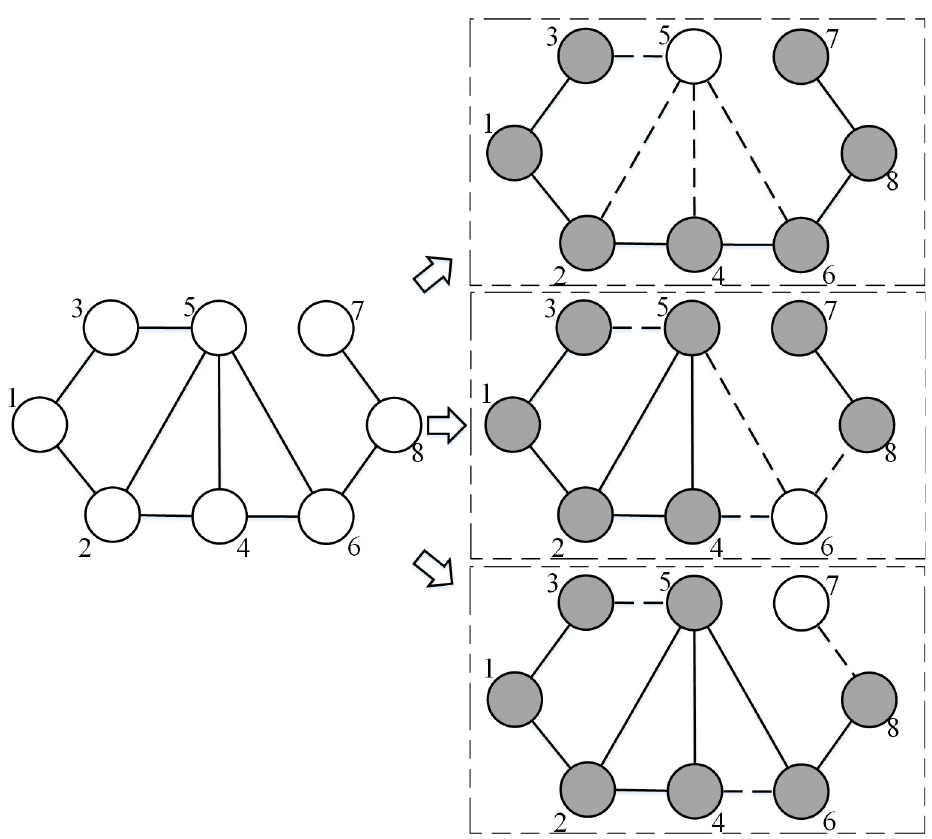
Fig 3. DkSP in solving the boundary specification problem. Grey nodes represent the included nodes and white nodes represent the omitted nodes. The dashed lines represent unobserved ties. The left network is the input network, while the three networks on the right represent the solution made up of extracted subgraphs. The upper right network excludes node 5 and becomes a ring; the middle right network excludes node 6 and becomes unconnected; the lower right network excludes node 7, and is the best solution of D k